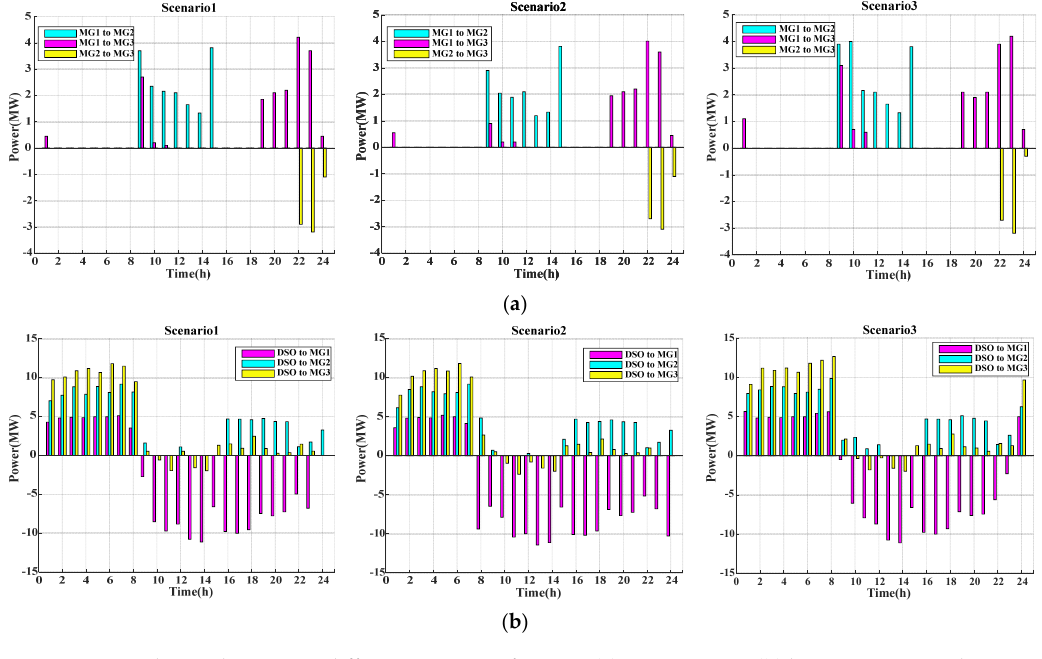
Figure 9. Exchanged power in different scenarios for CS1: ( a ) among MGs; ( b ) between DSO and MGs.